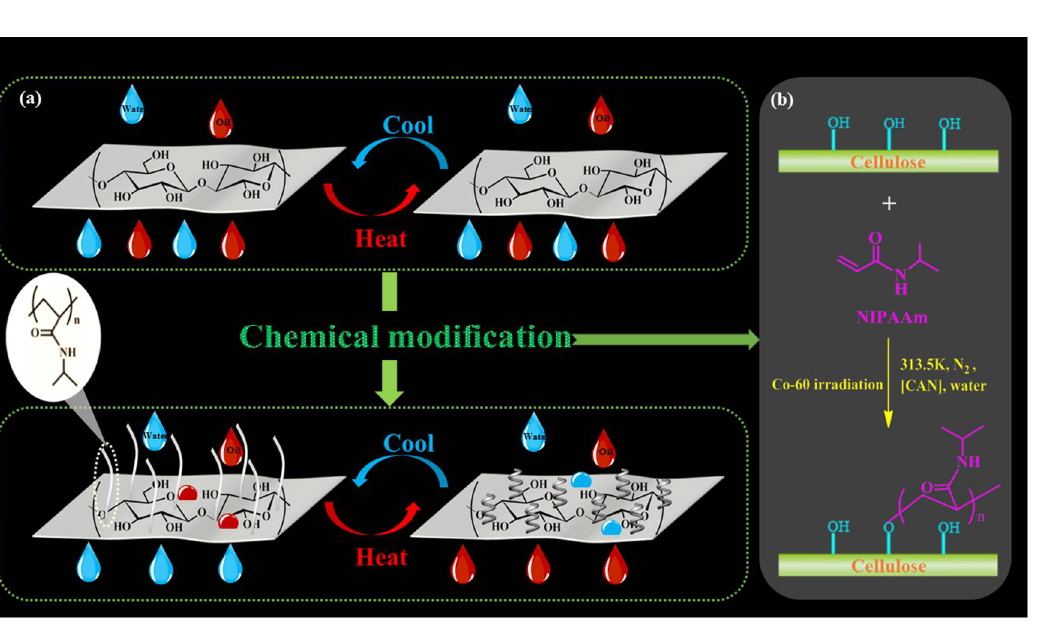
Figure 1. The fabrication of the cellulose- g -PNIPAAm paper through chemical modification ( a ); the schematic description of the preparation of cellulose- g -PNIPAAm ( b